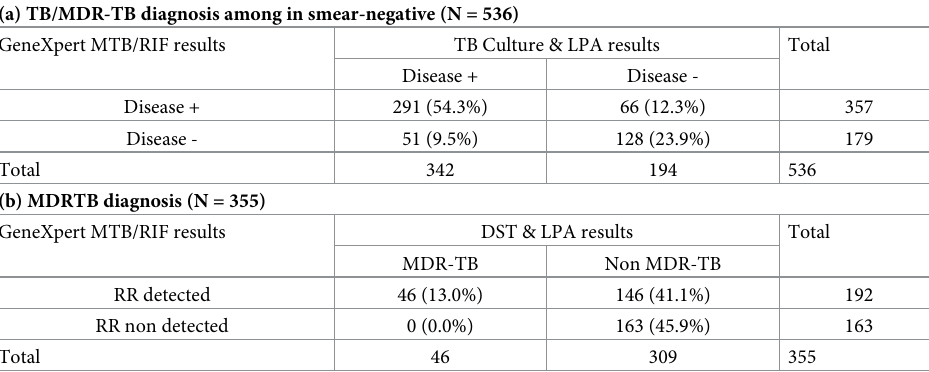
Table 3. Diagnostic performance of GeneXpert